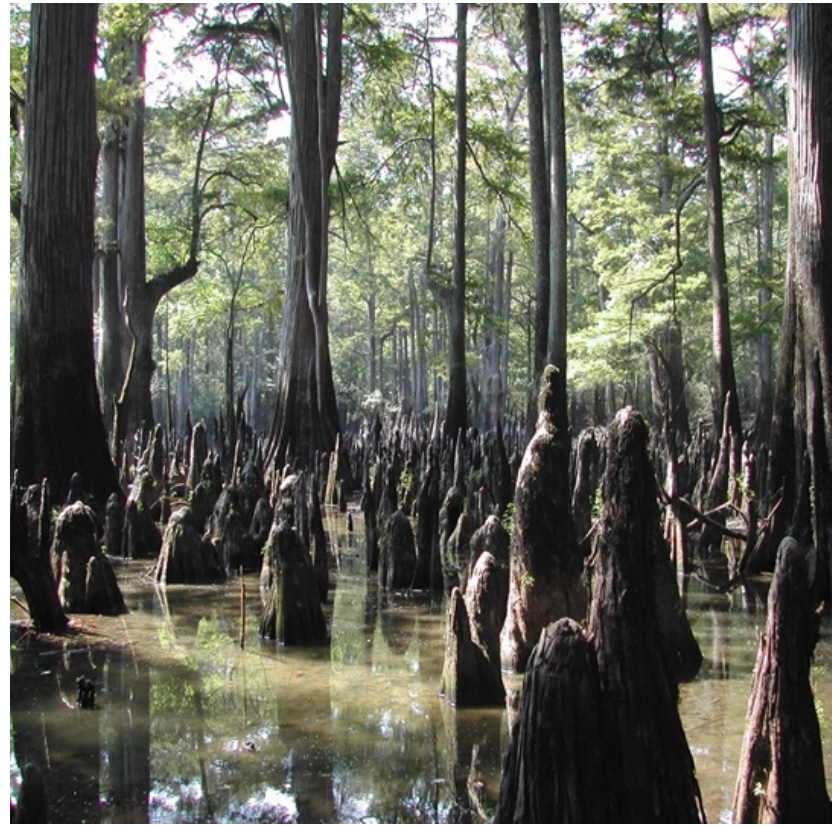
Figure 11. “Knees” emerging from the roots of baldcypress, Taxodium distichum (L.) Rich. in Arkansas, USA. From Middleton [112]. CC BY 4.0 license.